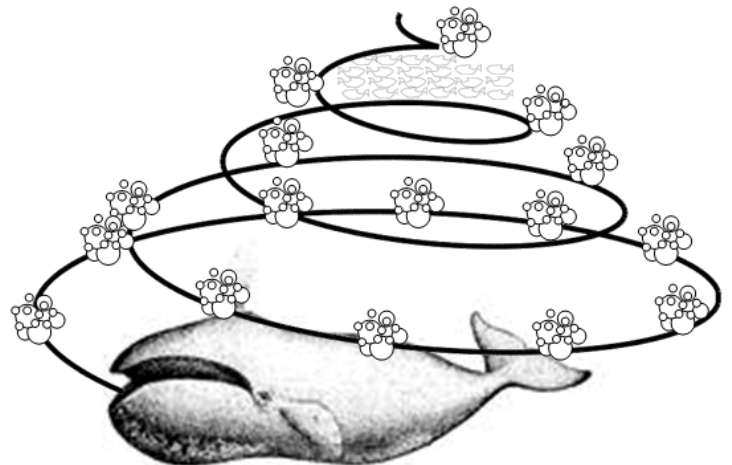
Figure 4. Bubble hunting of humpback whales [28].